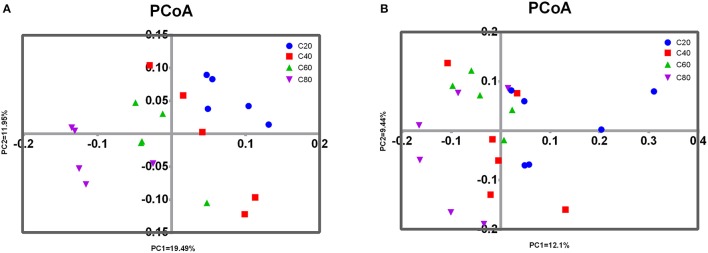
Principal coordinated analysis (PCoA) of fecal microbial communities. Unweighted PCoA by fecal bacteria (A) and archaea (B) microbiota. C20, diet containing 20% of concentrate; C40, diet containing 40% of concentrate; C60, diet containing 60% of concentrate; C80, diet containing 80% of concentrate.